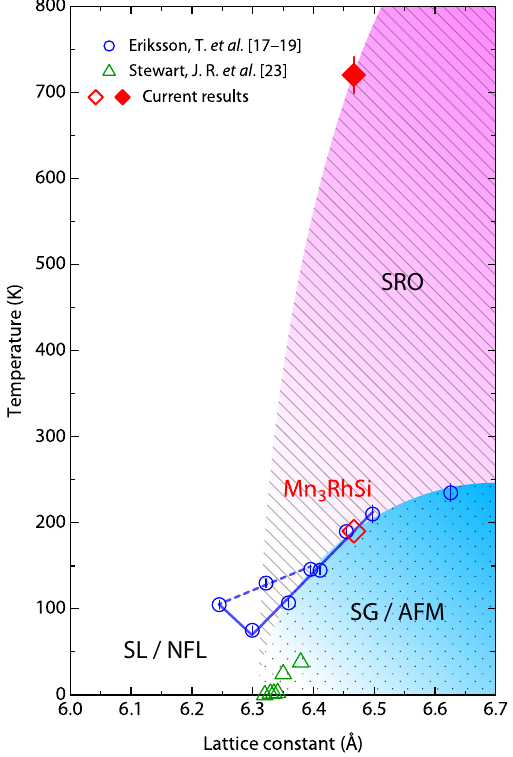
Fig. 6 Phase diagram of β -Mn structure compounds. Temperature results for the family of compounds with the β -Mn structure 17 – 19,23 as a function of the cubic lattice parameter, in addition to Mn 3 RhSi (open and closed diamonds). The open circles with error bars present results for Mn 3 CoSi, Mn 3 IrSi, Mn 3 CoGe, Mn 3 IrGe, and their binary compounds 17 – 19 . The open triangles present results for β -Mn 1- x Al x 23 . The result for the SL compound β -Mn occurs at 6.32 Å on the quantum critical point, where NFL behavior is observed 22 . SG behavior is observed in aluminum-doped β -Mn 23 , whereas the compound family of Mn 3 RhSi exhibits a long-range AFM